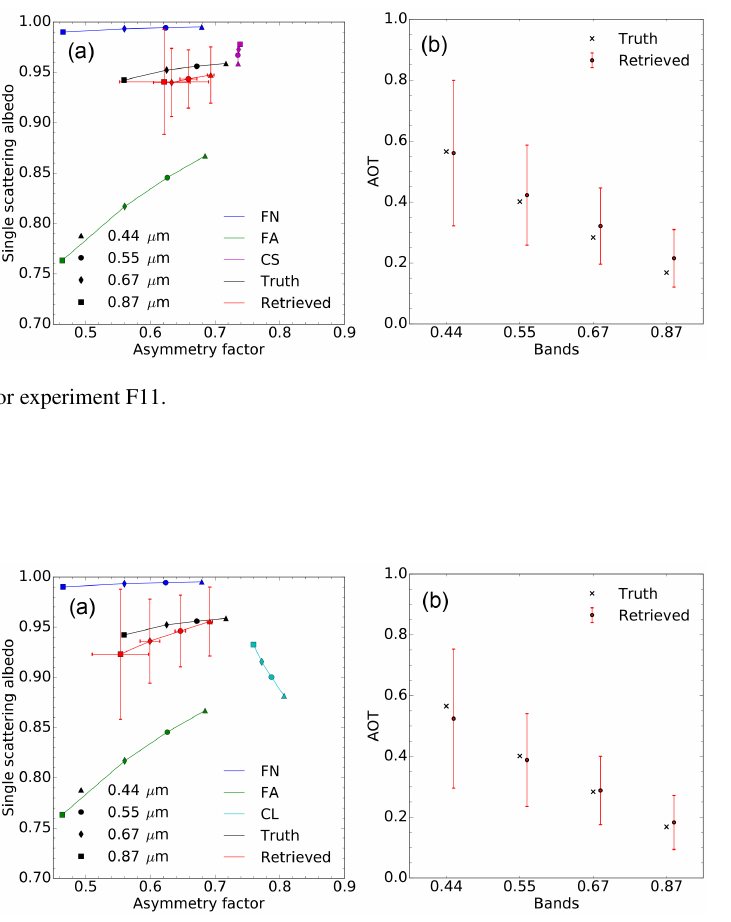
Figure 8. Same as Fig. 5 but for experiment F12.